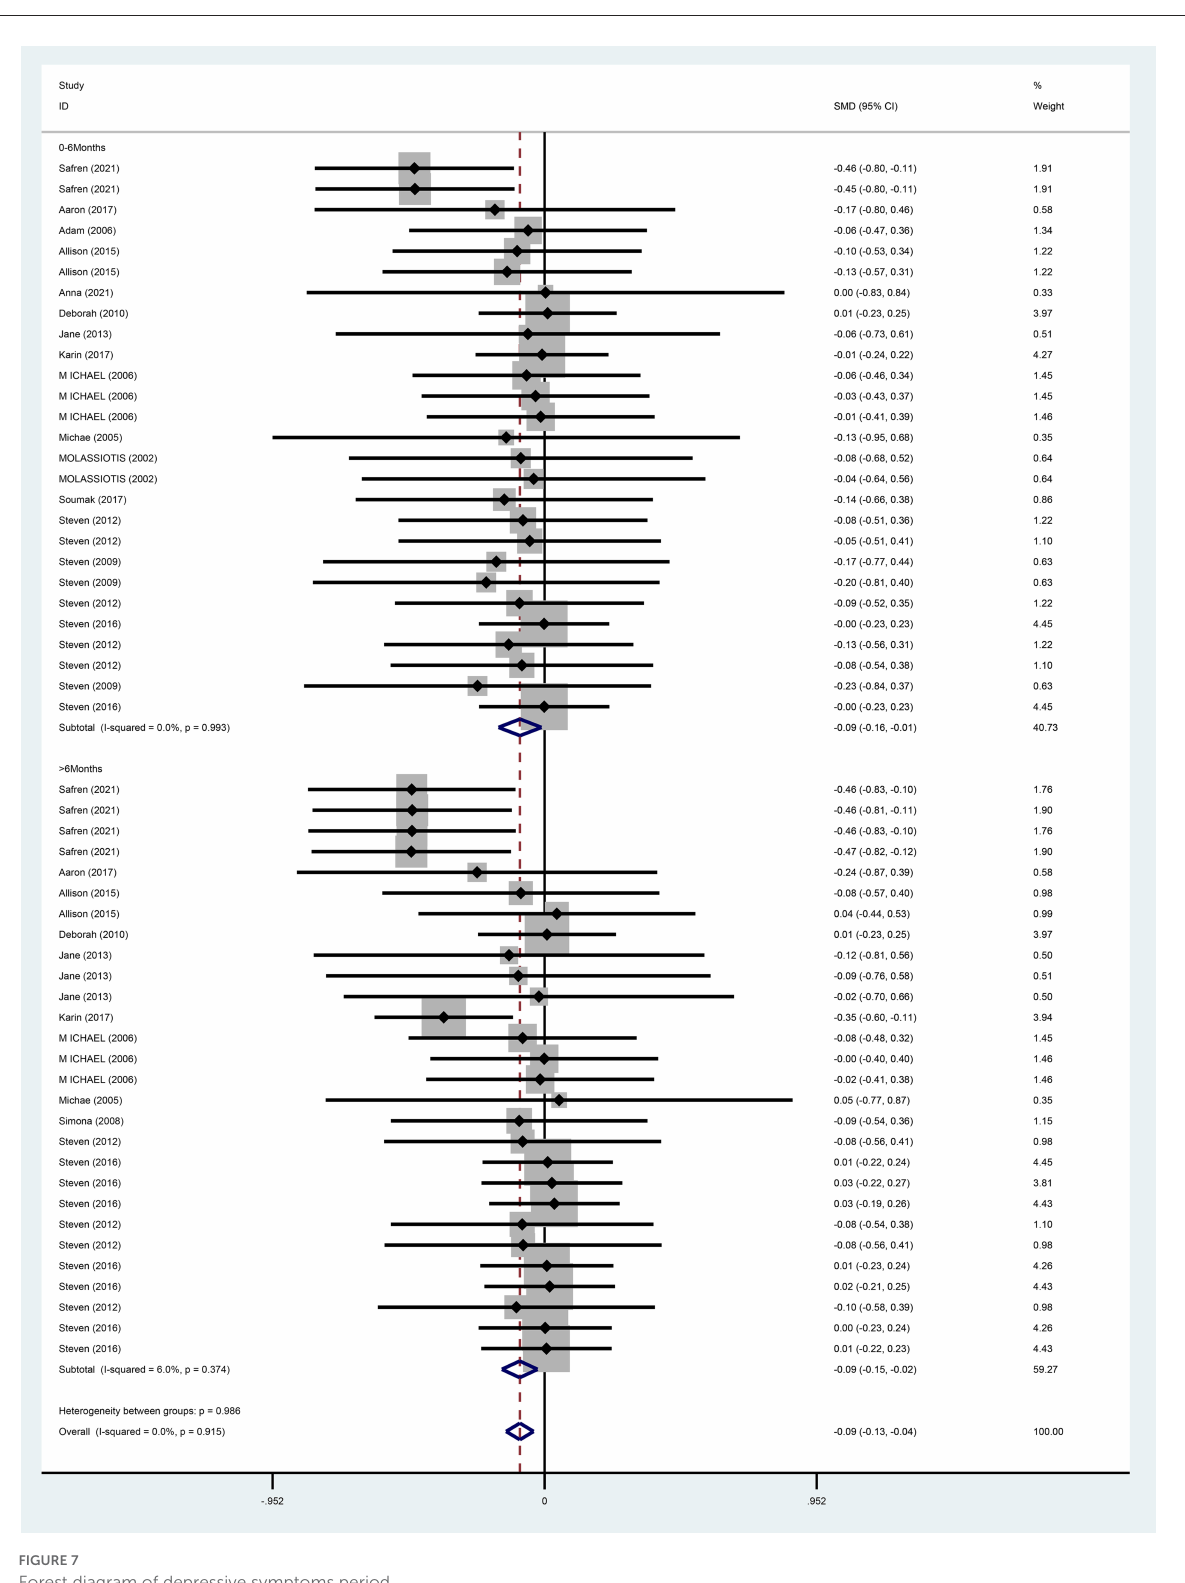
FIGURE7 Forest diagram of depressive symptoms